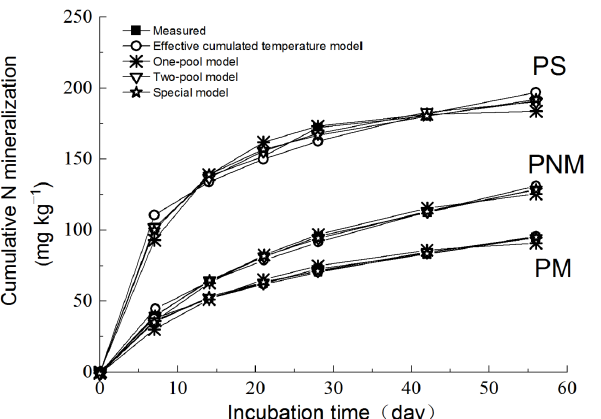
Figure 4. The cumulative nitrogen mineralization for the paddy field, P. plantation without mulching and P. plantation with mulching sites. PS, rice paddy soil; PNM, Phyllostachys praecox plantation without mulching; PM, P. praecox plantation with mulching. Bars are the mean ± standard error ( n = 3). Table 2. The N mineralization for the paddy field, P. plantation without mulching and P. plantation with mulching sites. Treatment